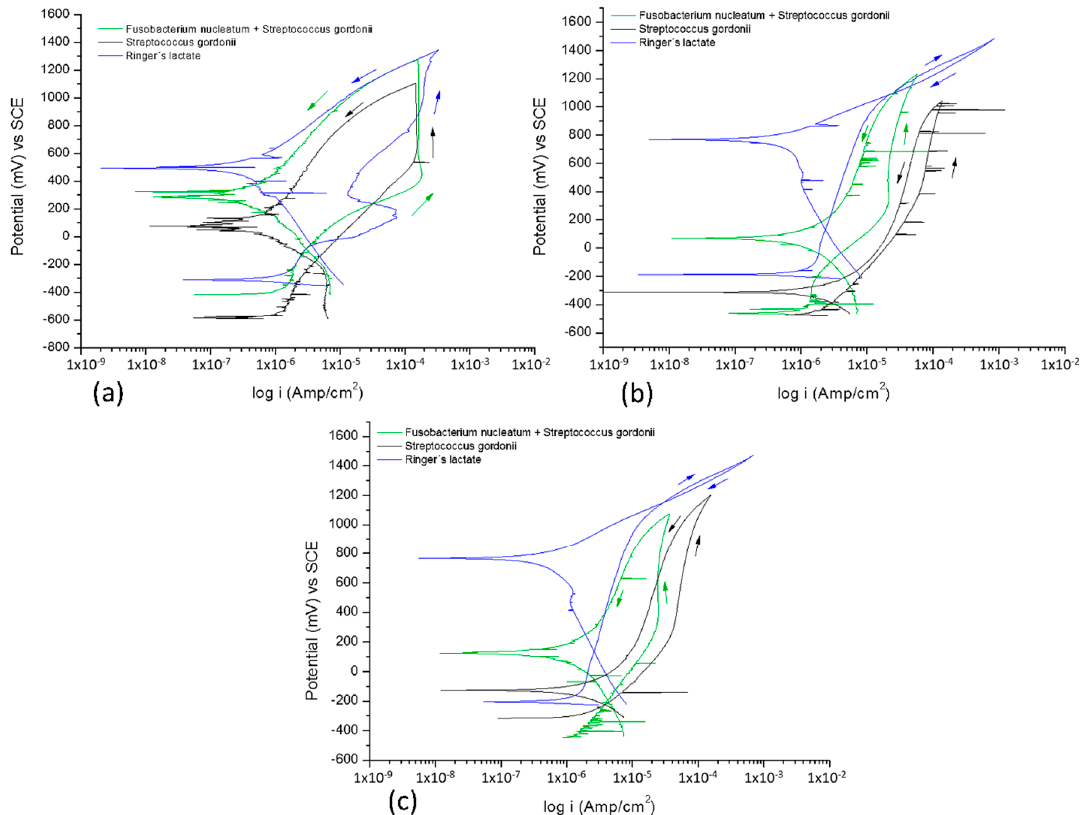
Figure 2. Cyclic potentiodynamic polarization of the Ti6Al4V alloy a 0 ( a ), 48 ( b ), and 96 ( c ) hours of exposure in: Fusobacterium nucleatum + Streptococcus gordonii ; Streptococcus gordonii ; and Ringer’s lactate at 37 °C.